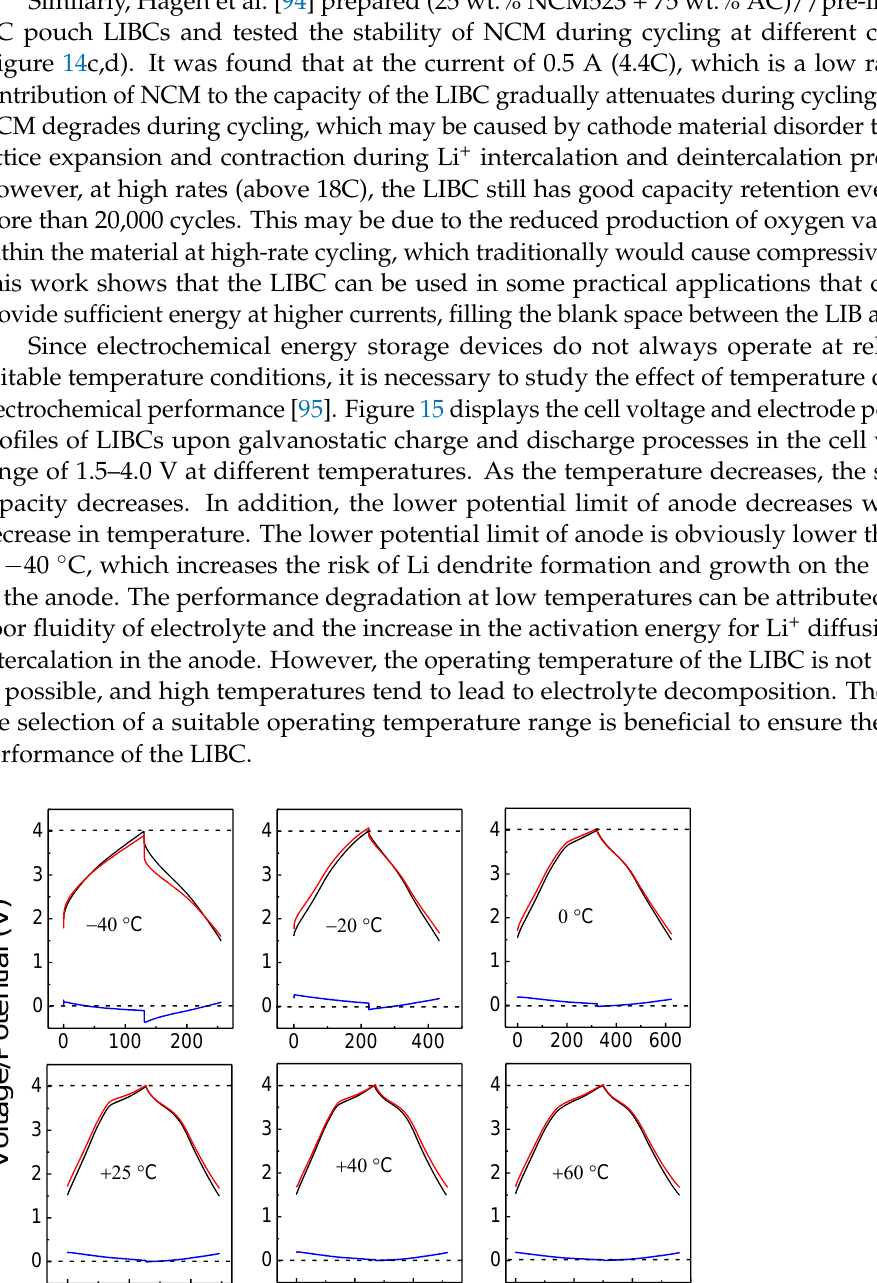
Figure 14. NCM-based LIBC: ( a ) Capacity failure mechanism; ( b ) Rate performance and cycle per- formance [93]. ( c ) Cycle performance; ( d ) Discharge profiles at different currents [94].